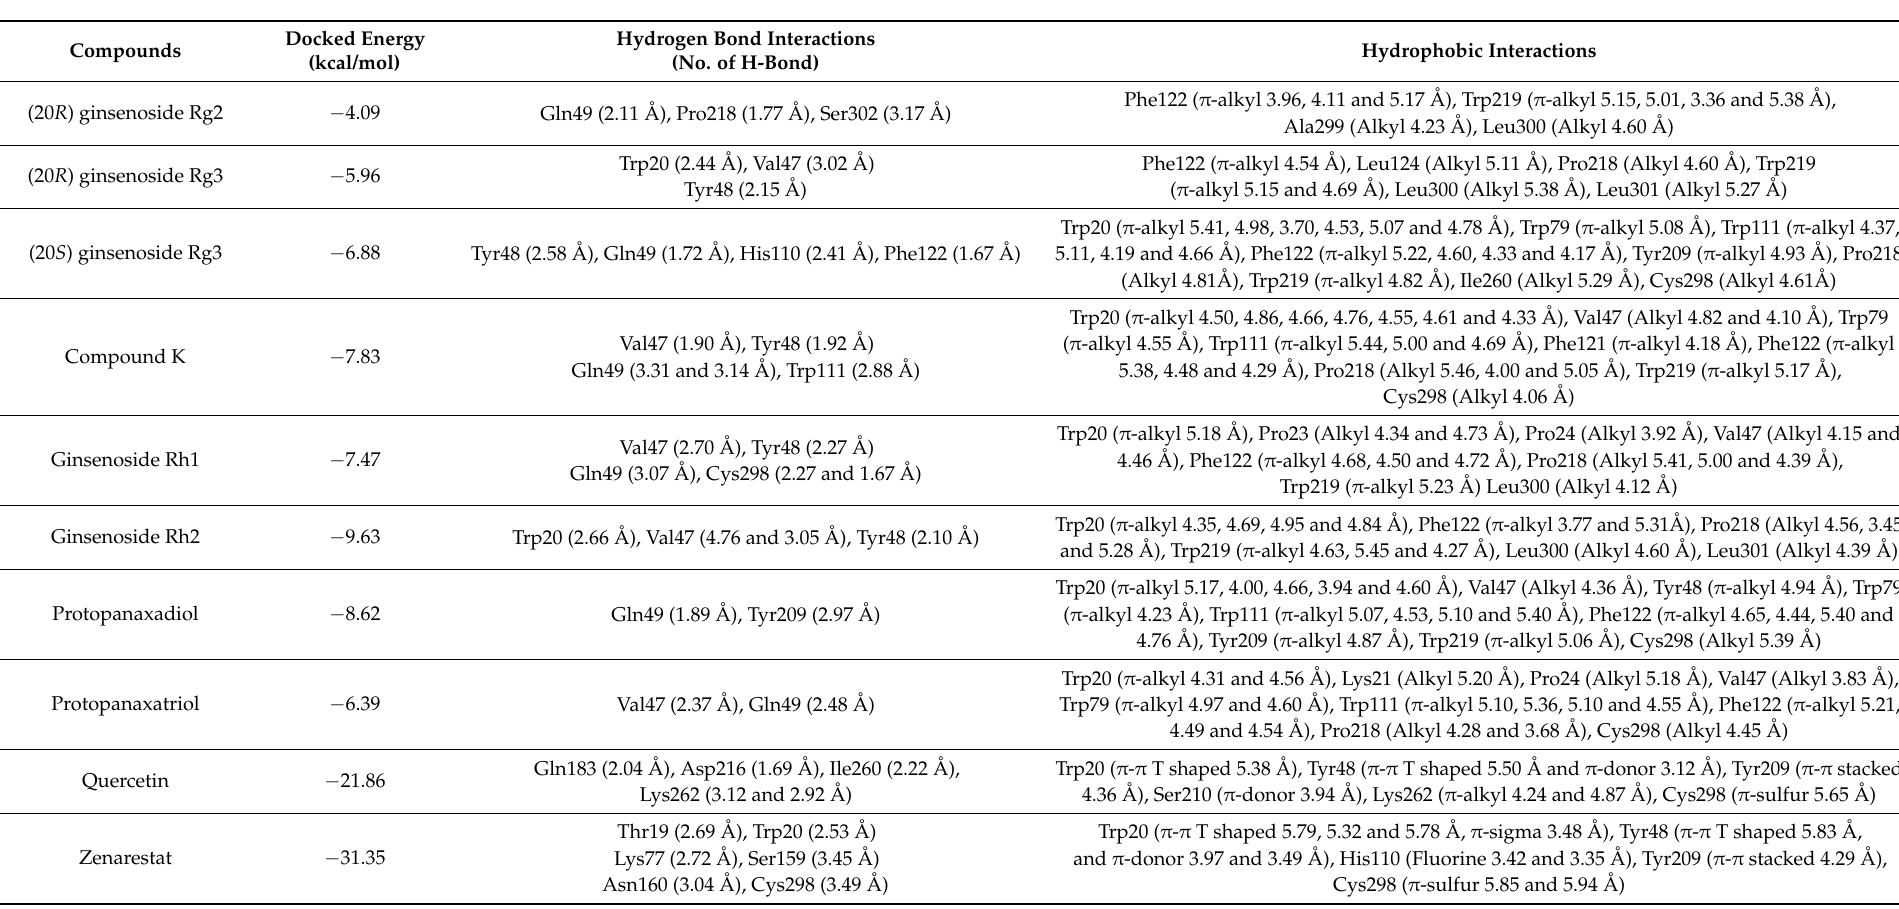
Table 3. Binding energies and binding interactions of ginsenosides with HRAR using the LeadIT docking program (FlexX) and visualization by Discovery Studio